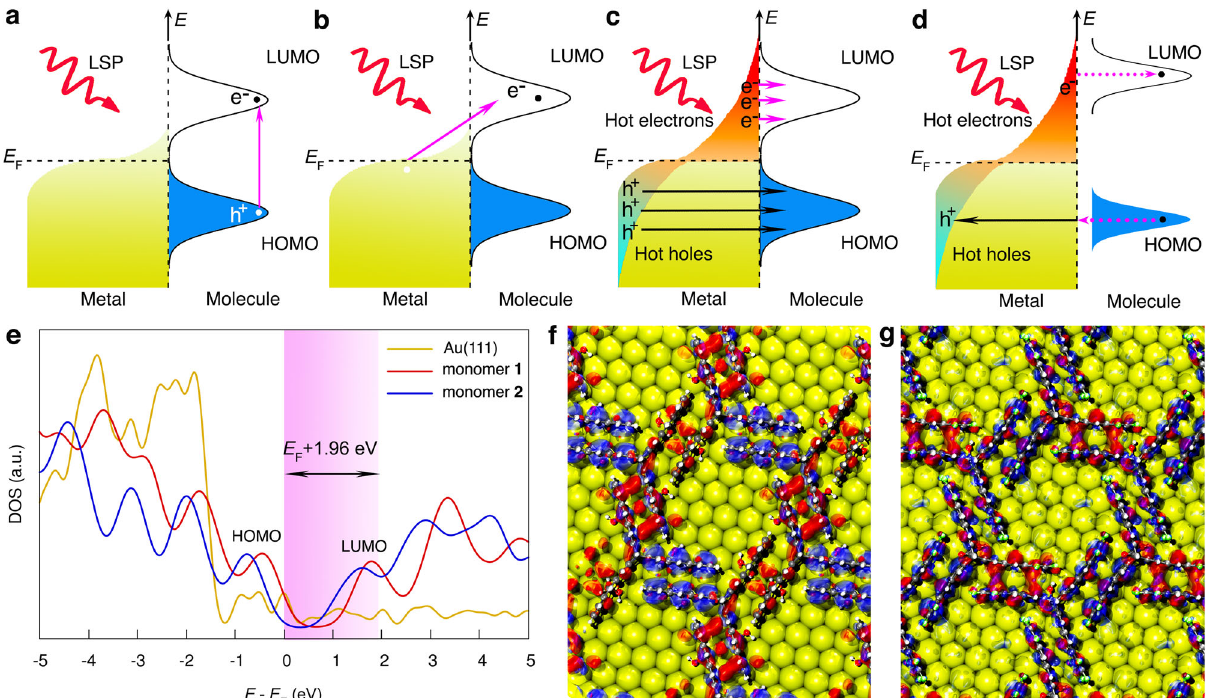
Fig. 3 Excitation mechanisms for plasmon-induced chemical reactions. a Direct intramolecular excitation for a HOMO-LUMO transition. b Charge transfer mechanism from metal surfaces to adsorbate unoccupied states. c , d Indirect hot-carrier transfer from the metal surface to unoccupied states of the adsorbate c with and d without adsorbate/surface hybridization through inelastic tunneling processes. The localized surface plasmon (LSP) is a result of the strong coupling between metal-free electrons and incident electromagnetic fi eld in the con fi ned plasmonic system. Black and white dots indicate electrons (e − ) and holes (h + ), respectively. e The calculated projected DOSs of monomer 1 and 2 MLs on Au(111). The energy distribution of the hot electrons in the hotspots are highlighted. f , g The spatial distribution of the (blue) HOMO and (red) LUMO levels for monomer f 1 and g 2 MLs on Au(111), respectively. a.u. arbitrary